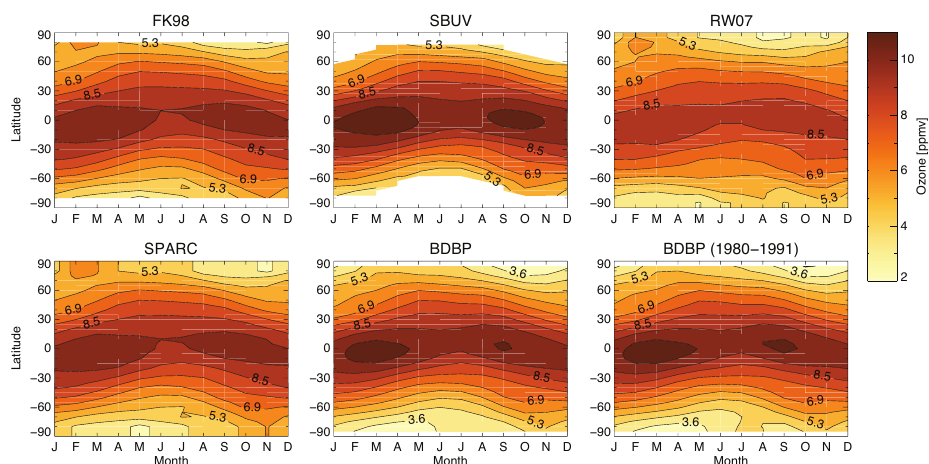
Fig. 1. Ozone climatologies at 10hPa as a function of latitude and month, for the Fortuin & Kelder climatology (FK98), a climatology derived from SBUV measurements (period 1979 to 2005; SBUV), for the three different data sets (RW07, SPARC and BDBP) calculated for the period 1979 to 2005, and for the BDBP data set calculated for the shorter period 1980 to 1991 (BDBP (1980–1991)). Dark orange/brown represent high ozone values, light orange represent low ozone values.